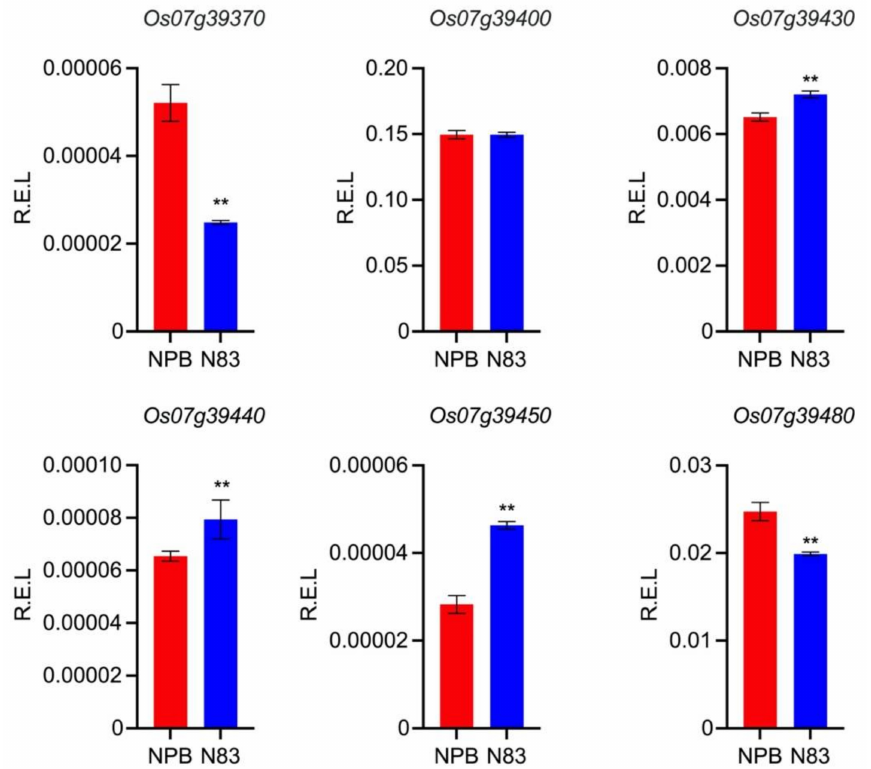
Figure 7. Expression analysis of qTGW7b candidate genes. Data are mean ± SD with three tech- nical replicates, Student’s t -test was used to generate the p values, ** p < 0.01. R.E.L: Relative expression